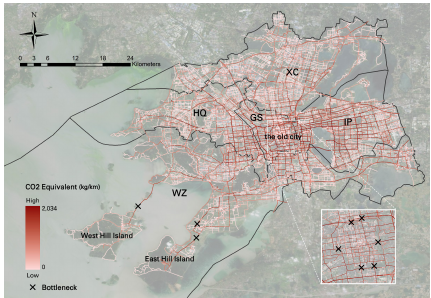
Figure 6. Total emissions of each